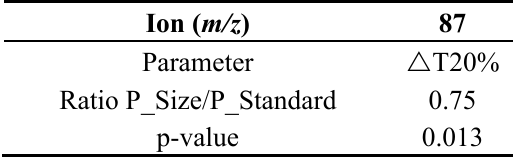
Table 4. Value ratio of characteristic parameters that significantly differ between P_Size and P_Standard products. Characteristic parameters were extracted from in vivo release curves (only parameters with significant differences at 5% are shown).